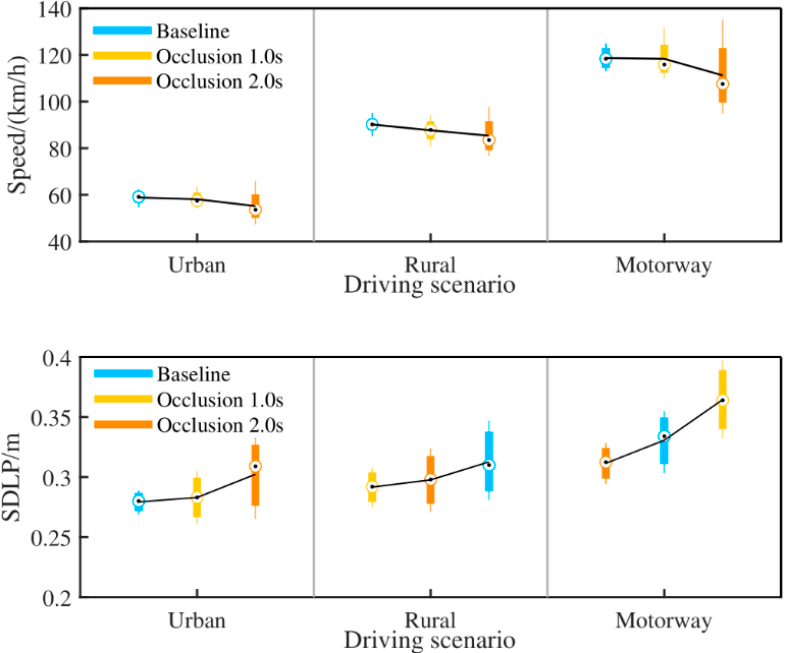
Figure 3. Boxplot of driving speed ( top ) and SDLP ( bottom ) per occlusion duration in scenario. For each box, the central mark is the median, and the mean values are lined with solid black lines.